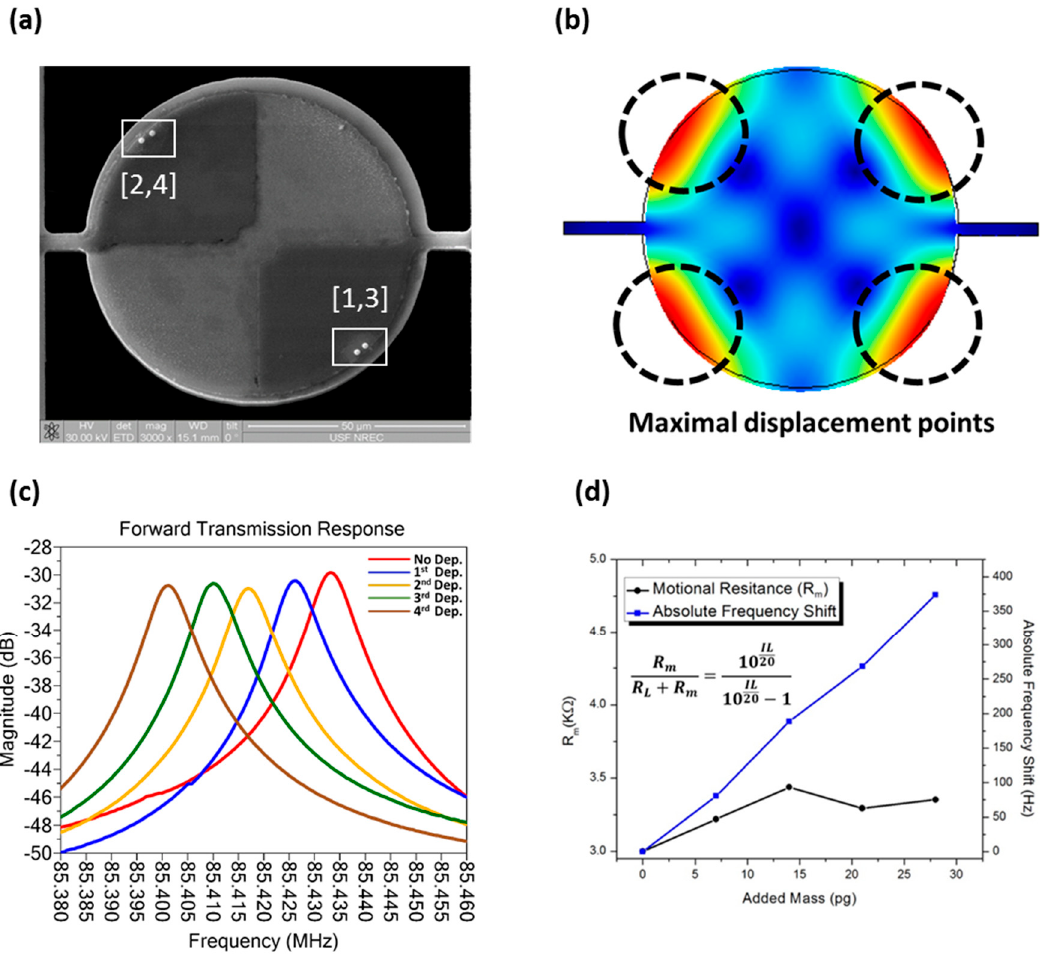
Figure 8. ( a ) SEM image of showing the location of sequentially deposited Pt/Ga micro-pellets at the maximum displacement points; ( b ) COMSOL® modal simulation illustrating the maximum displacement areas of the corresponding fourth-order contour mode; ( c ) measured frequency responses showing the frequency drift induced by the added extra mass of each micro-pellet; ( d ) measured absolute frequency shift and motional resistance ( R m ) of the device versus loaded mass verifying negligible impacts of the micro-pellets made to the signal strength (insertion loss) and energy dissipation